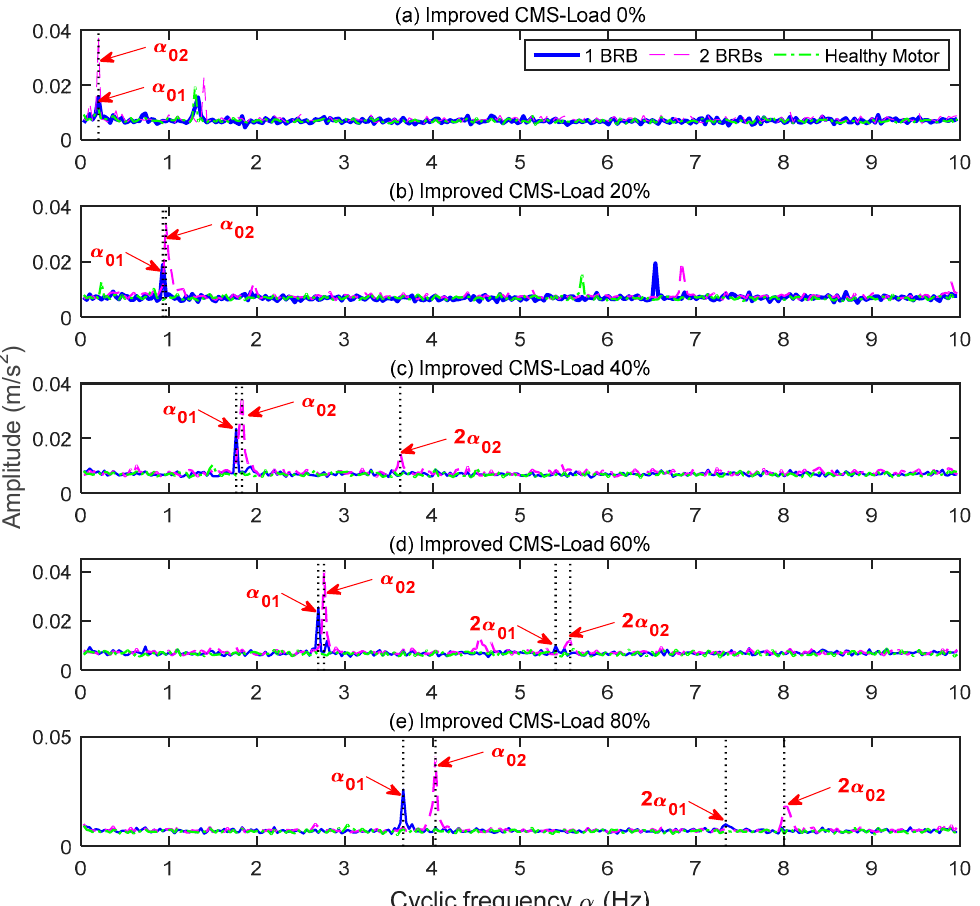
Figure 10. The characteristic frequencies of α 01 and α 02 for 1 BRB and 2 BRBs based on the improved CMS method at ( a ) 0% load, ( b ) 20% load, ( c ) 40% load, ( d ) 60% load, and ( e ) 80% load under operating conditions. Blue for 1 BRB, Pink for 2 BRBs, and Green under healthy motor. Table 6. The different characteristic frequencies detected by four methods under different loads.